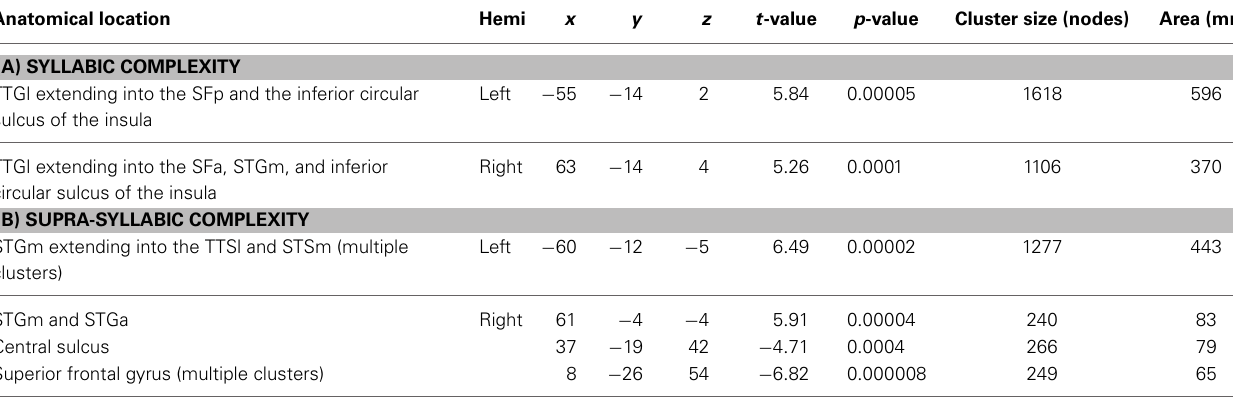
Table 4 | FWE-corrected whole-brain BOLD results.